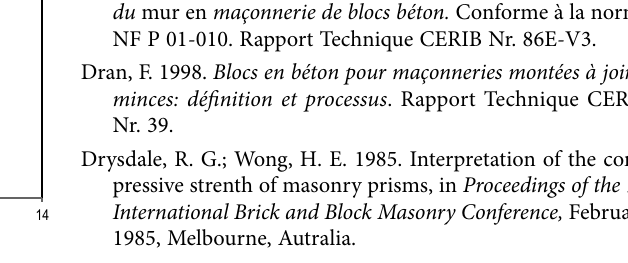
Fig. 10. Characteristic compressive strength of the tested masonry and comparison with Eurocode